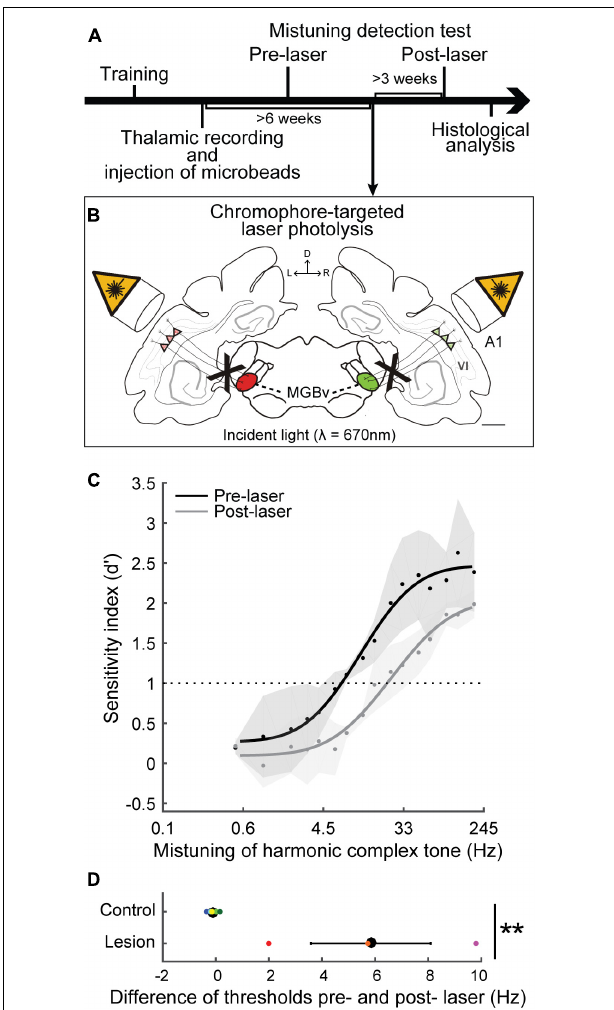
FIGURE 6 | Selective elimination of corticothalamic neurons in layer VI impaired mistuning detection performance. (A) Ferrets were trained for a mistuning detection task using go/no-go behavior paradigm. The fluorescent microbeads conjugated with a light-sensitive chromophore were injected into bilateral MGBv (left, red; right, green) guided by thalamic recordings. (B) Apoptosis was induced for the retrogradely labeled corticothalamic neurons in layer VI by infrared laser light on A1. D, dorsal; L, left; R, right; VI, cortical layer 6. Scale bar = 1 mm. (C) The psychometric curves were plotted as a function of degree of mistuning (on a log scale). X-axis indicates less mistuning at the left and larger mistuning toward the right. Mistuning detection performance was impaired, shifting the curve toward larger mistuning after selective elimination of corticothalamic neurons (gray) compared to the baseline (black). (D) The difference of threshold before and after laser illumination was larger for the animals that received corticothalamic elimination compared to the control animals (two-tailed unpaired t test, ** p < 0.01), supporting impaired behavior by a loss of A1-MGBv corticothalamic feedback. Individual animals are represented by colored dots (Adapted and modified from Homma et al., 2017; Figures 3D,F,